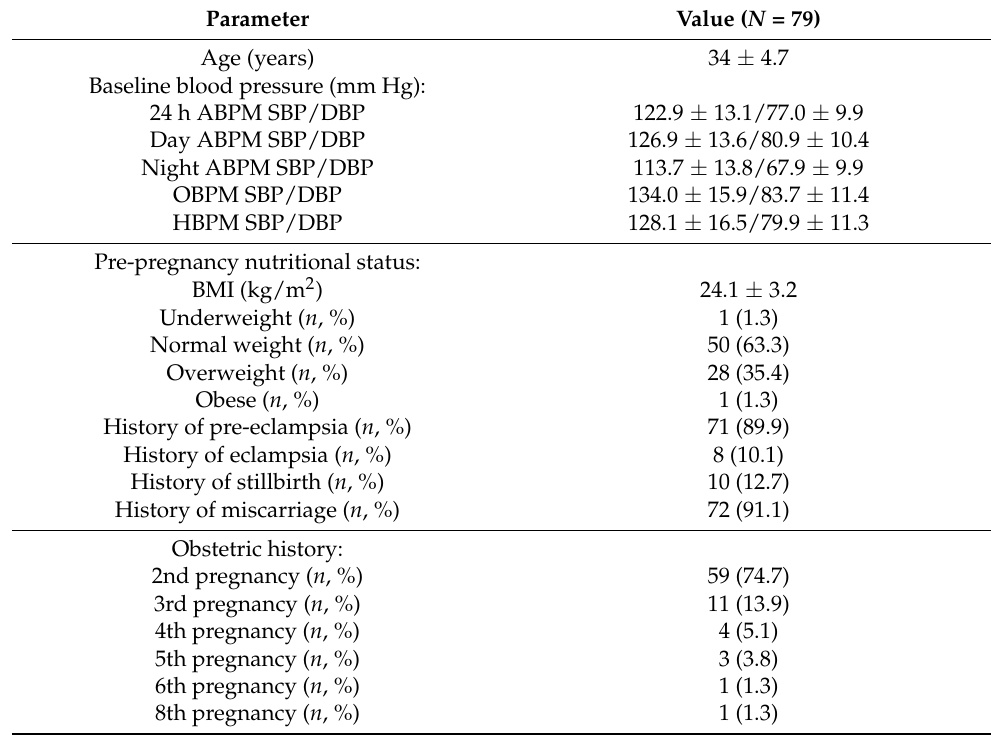
Table 1. Clinical characteristic and pregnancy outcomes.